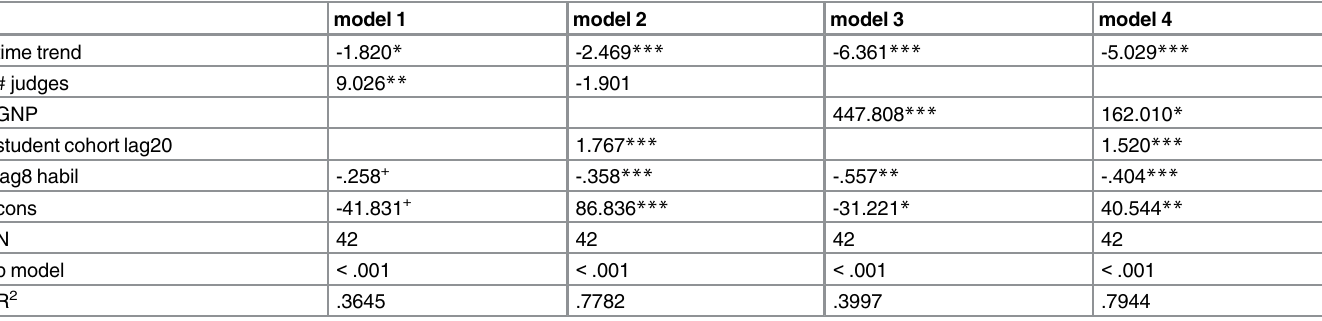
Table 3. Adding Measures for Alternative Career